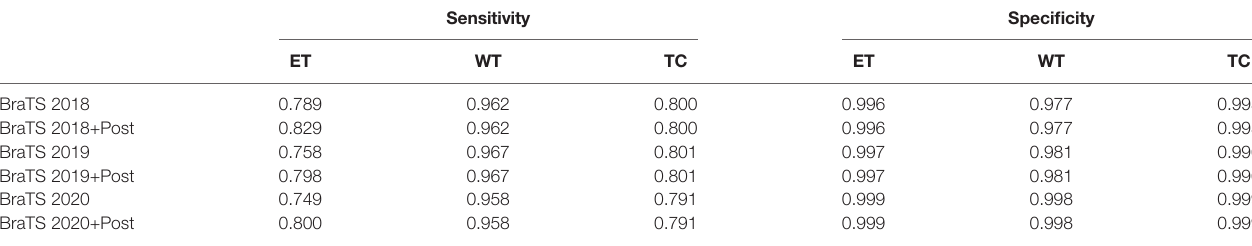
TABLE 2 | Comparison of Sensitivity and Speci fi city post-processing of three validation